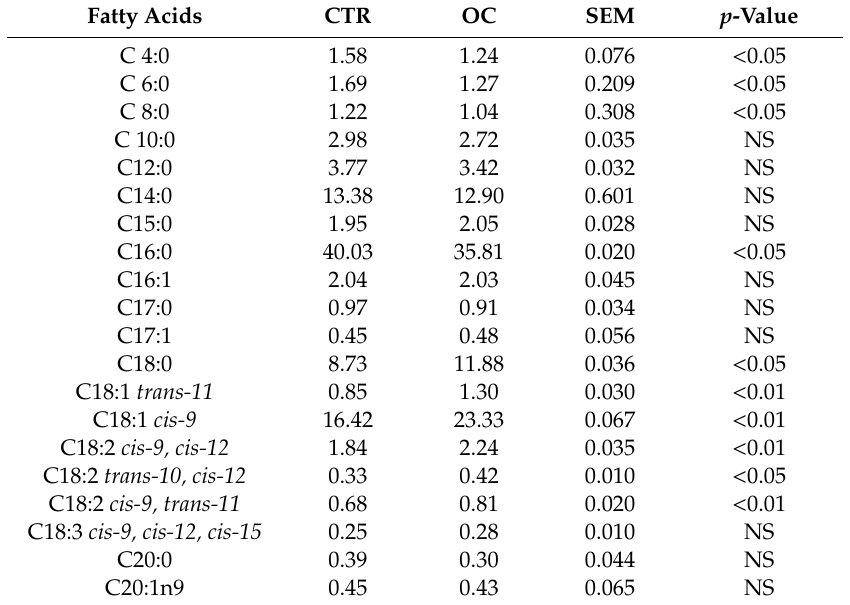
Table 7. E ff ect of olive cake supplement on cheese fatty acid profile (g / 100 g) § after 60 days of ripening. Fatty Acids CTR